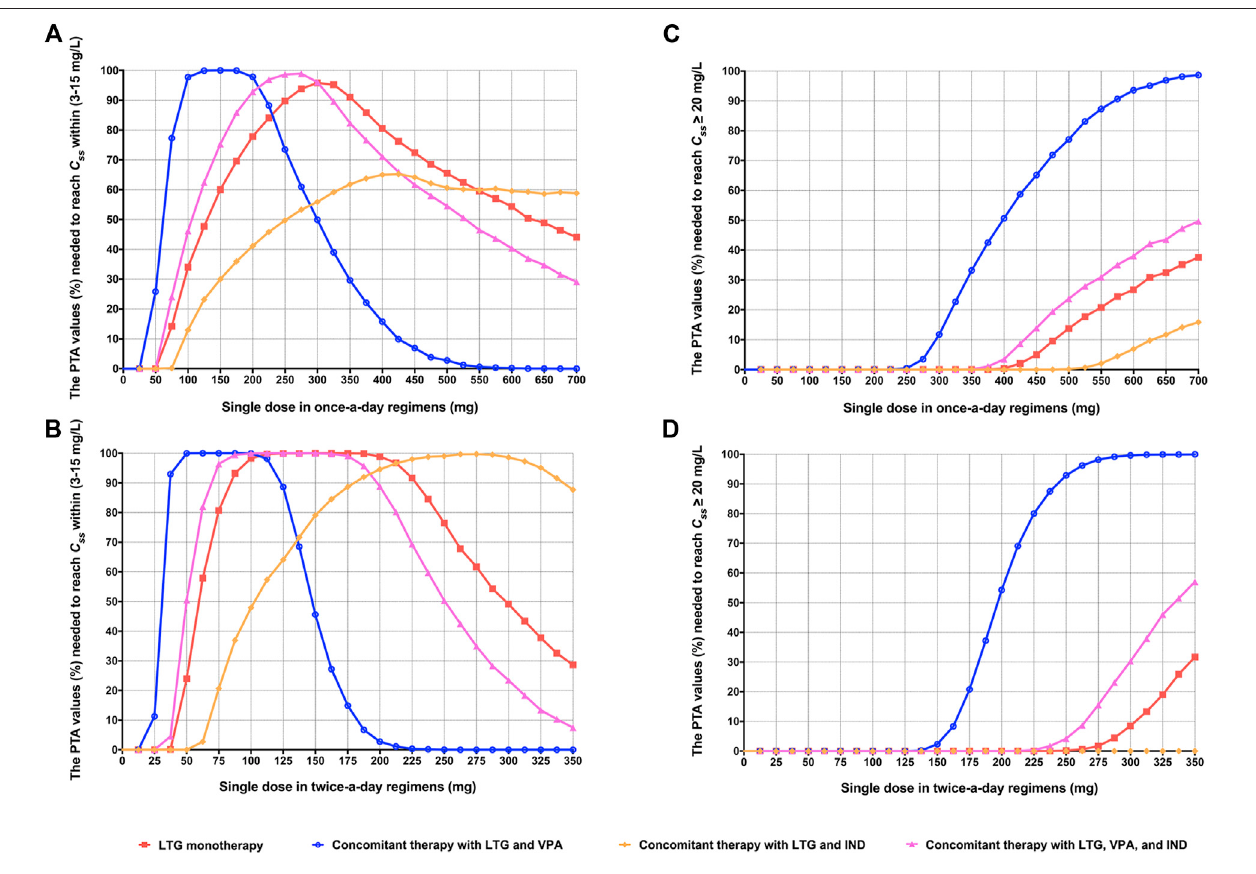
FIGURE 2 | The evolution of the probability of target attainment (PTA) values (%) needed to reach steady-state serum concentrations ( C ss ) within the target range (3 – 15 mg/L) and ≥ 20 mg/L for different once-daily regimens (A , C) and twice-daily regimens (B , D) in different scenarios of concomitant therapy in adolescent Chinese epilepticpatientsweighing60 kg,obtainedbyusingMonteCarlo(MC)simulations.Thesolidnodeinthecurverepresentstheresultofakindofassumeddosingregimen.